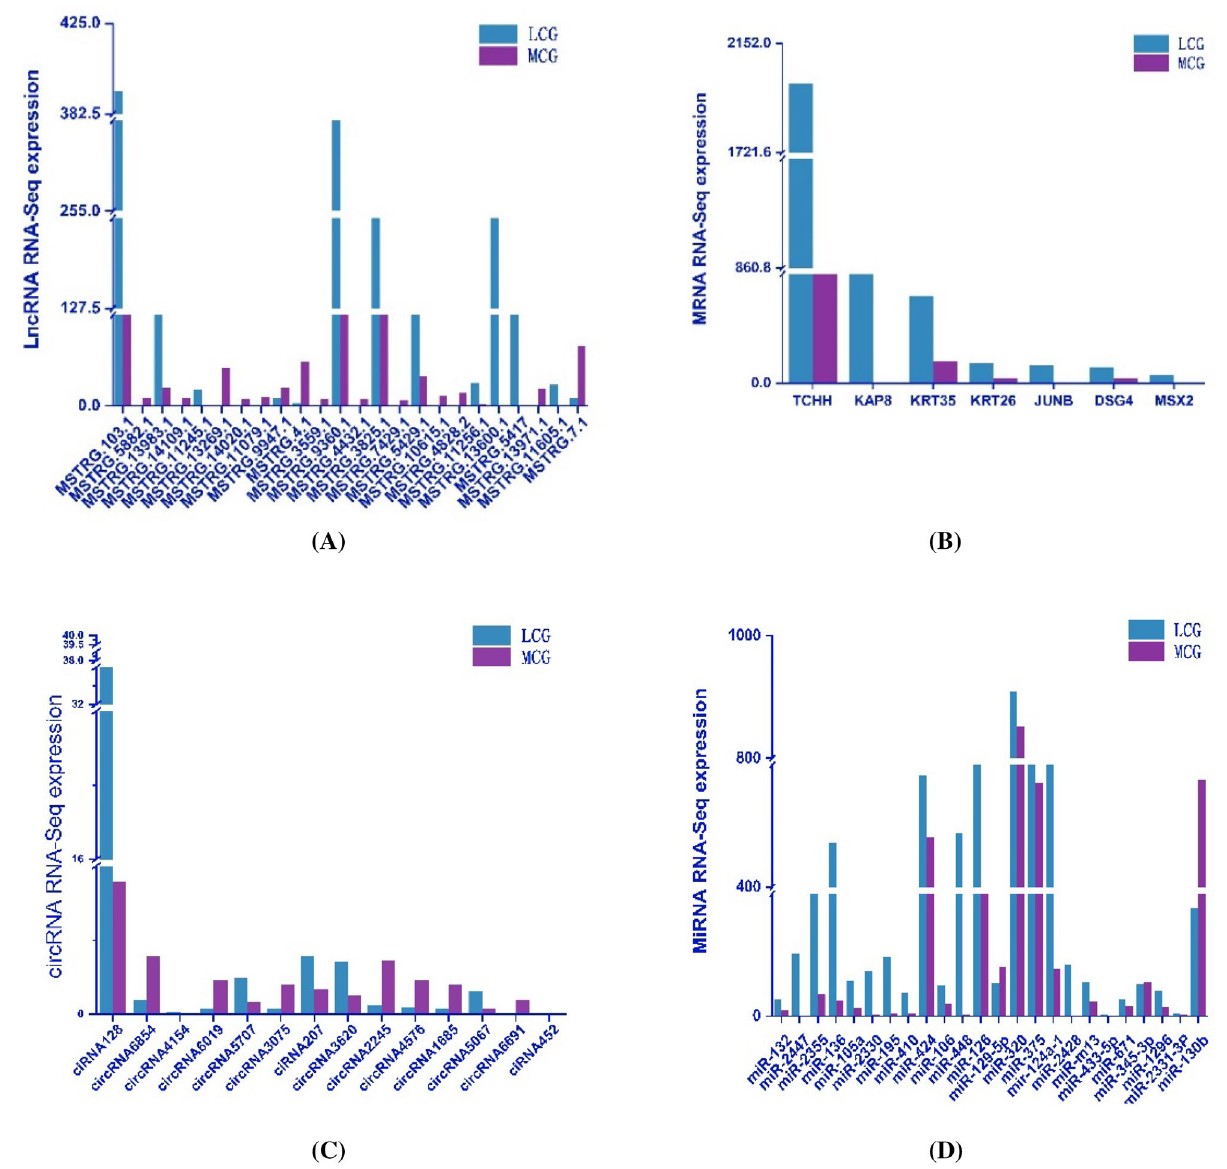
RNA-seq. ( C ) DEcircRNAs between LCG and MCG in RNA-seq. ( D ) DEmiRNAs between LCG and MCG in